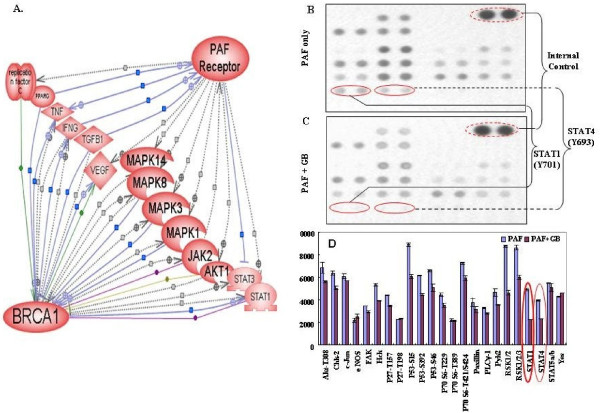
Bioinformatic pathway and protein-protein interaction between PAFR-BRCA1. (A). Pathway Studio software (Ariadne Inc.) and Human ResNet Mammalian Database were used in the study. Antibody microarray based protein kinase profiling and identification of STAT1 and STAT4 in BRCA1-mutant and PAFR-over expression (PAFR+) ovarian epithelial cancer cells. UWB1 cells were treated with PAF (100 nM) for 24 hours. Images of kinase arrays of signals after the incubation with 310 μg protein lysate of UWB1 cells treated with 100 nM PAF only (B) or with combination of 100 μM ginkgolide B (GB) and 100 nM PAF (C). The duplicated internal positive controls were used to calibrate the detection signal of membranes of the treated and untreated experiments. The summary of kinase expression profile of the UWB1 cells with different treatments and significance comparison by the paired student t-test (D).